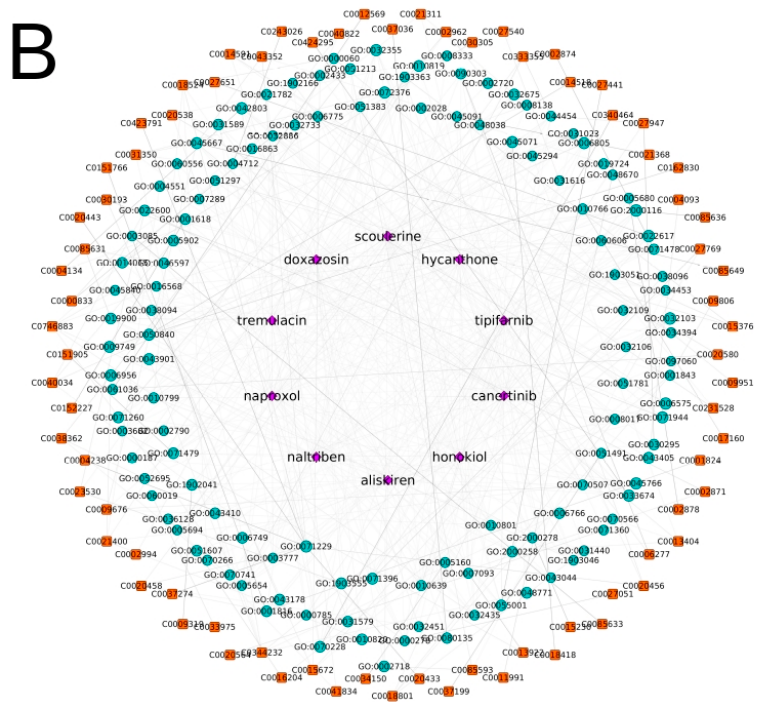
Figure 2. Tripartite Drug–GO–ADR network. Drugs are represented by purple diamonds, which are connected to Gene Ontology (GO) terms, represented by blue circles, which may be perturbed by the drug. In turn, GO terms are connected to those adverse drug reactions (ADRs), represented by red squares, that may manifest if said GO term is perturbed. In panel ( A ), the full network is shown. Panel ( B ) shows a subgraph of 10 (arbitrarily selected) drugs with their associated GO terms and ADRs.